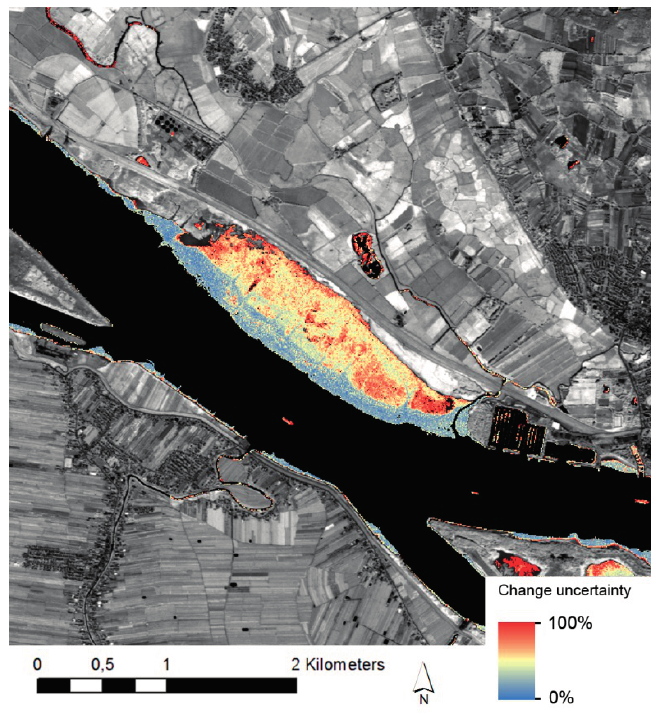
Figure 8. Change uncertainty for “water to non-vegetated